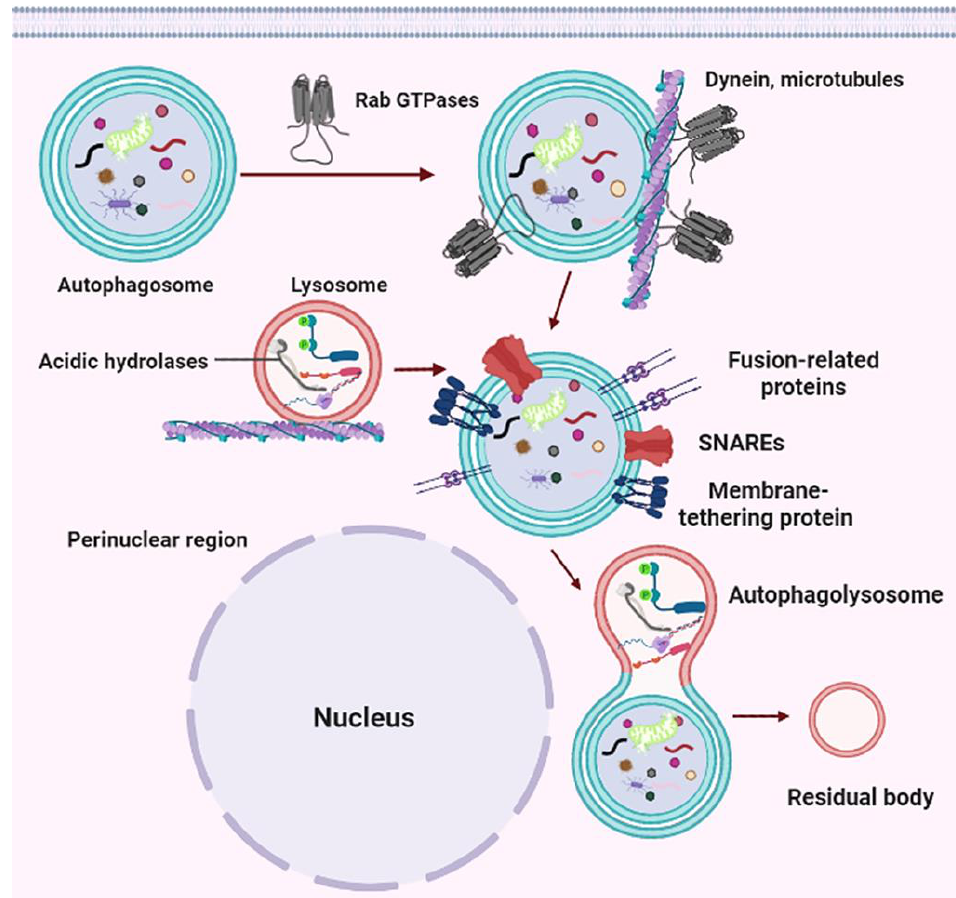
Figure 6. Schematic for the trafficking of autophagosome, formation of autophagolysosome, and release and reuse of degradation products in macroautophagy. Abbreviations: SNAREs, the soluble N-ethylmaleimide sensitive fusion protein attachment protein receptor.